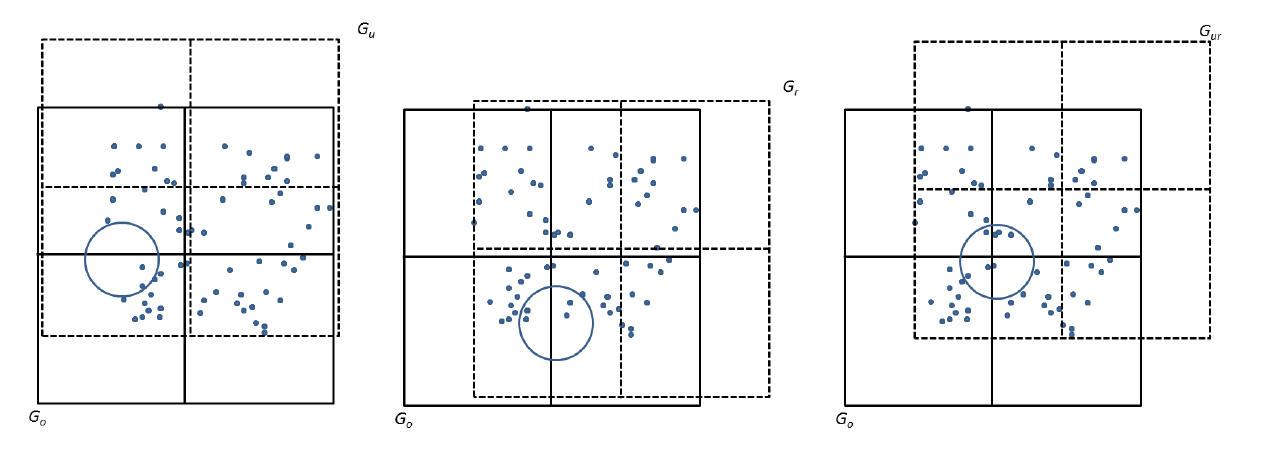
Fig. 1: Every unit disk is fully contained in a single cell of a grid G ∈ { G o , G u , G r , G ur } .